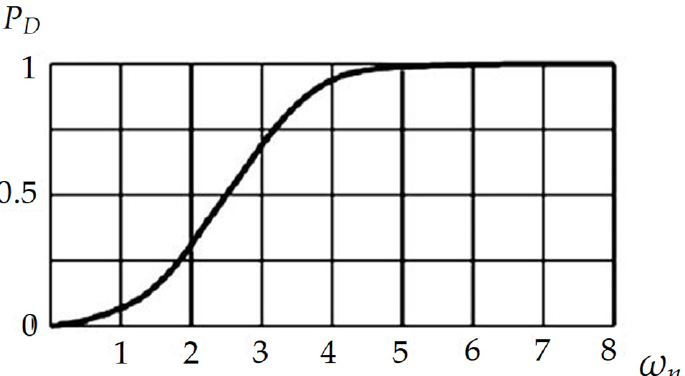
Figure 2. An example of return pulse detection probability as a function of the